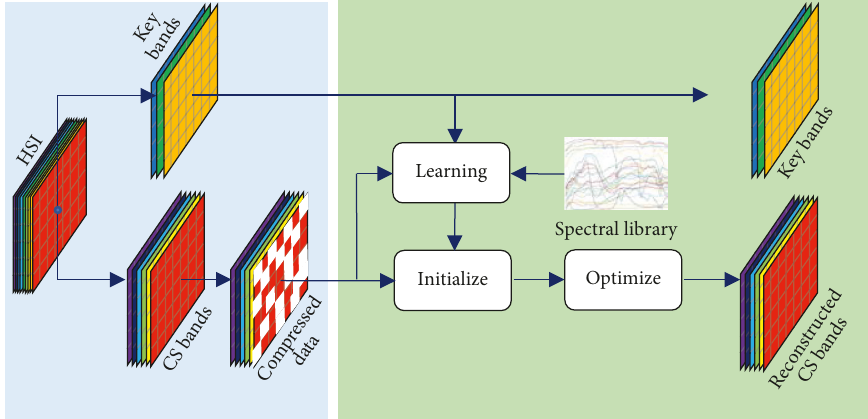
Figure 1: Illustration of the proposed framework. On the left side is the compressed sampling part, which is realized by optical hardware. On the right side is the reconstruction end with the support of a spectral